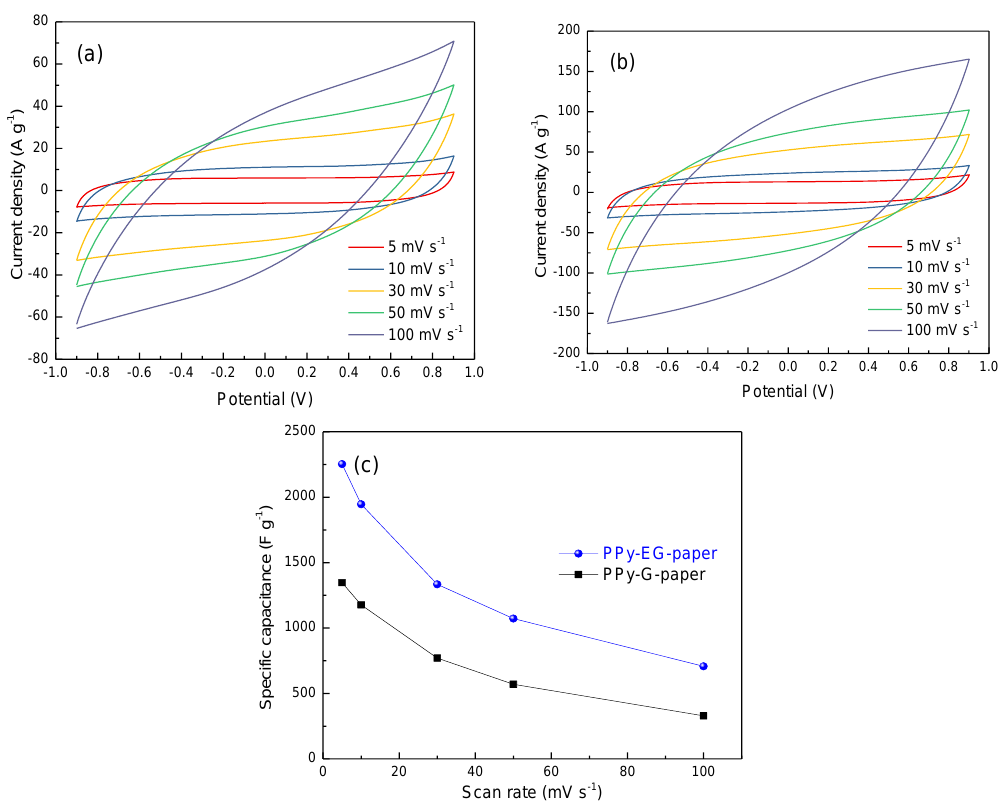
Figure 6. CV curves of ( a ) PPy-G-paper and ( b ) PPy-EG-paper at different scan rates; and ( c ) specific capacitance of PPy-G-paper and PPy-EG-paper at different scan rates.